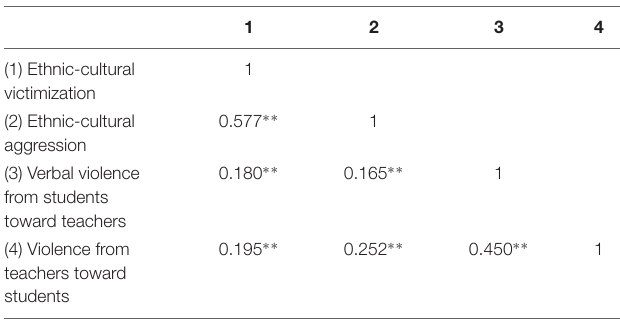
TABLE 4 | Spearman’s rho – ethnic-cultural bullying and CUVE 3 -ESO